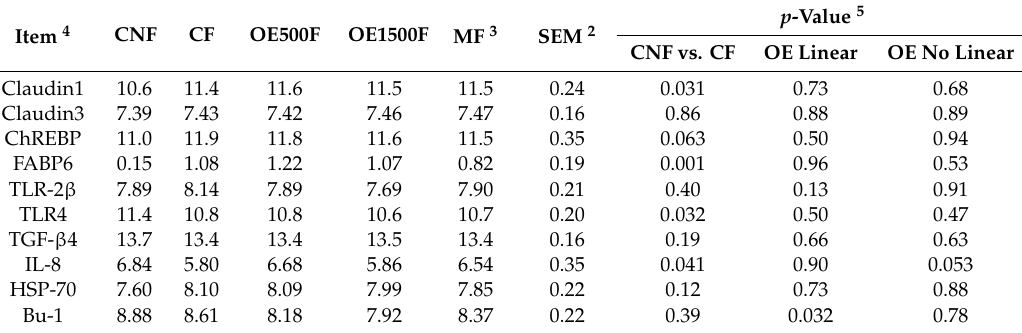
Table 6. E ff ect of a short-term (15.5 h) fasting period and experimental diets on ileum gene expression 1